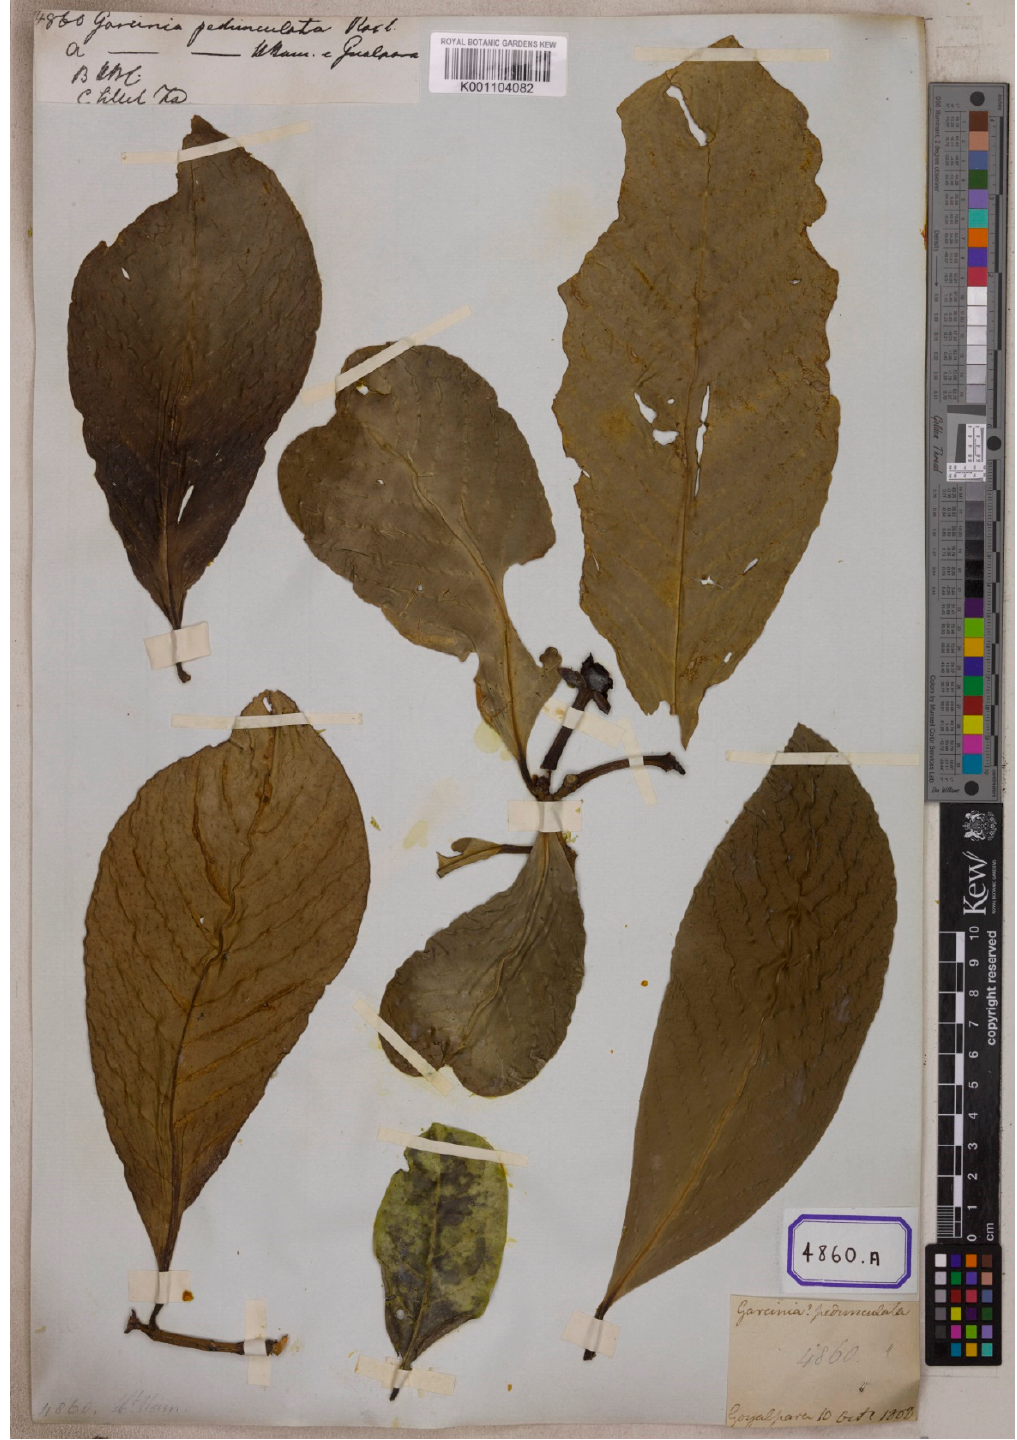
Figure 9. Isolectotype of Garcinia pedunculata , Buchanan-Hamilton collection , East India Company Herbarium 4860A (K-W [K001104082!]) from India, Goalpara, with female flowers (http://specimens.kew.org/herbarium/K001104082, accessed on 16 February 2022).